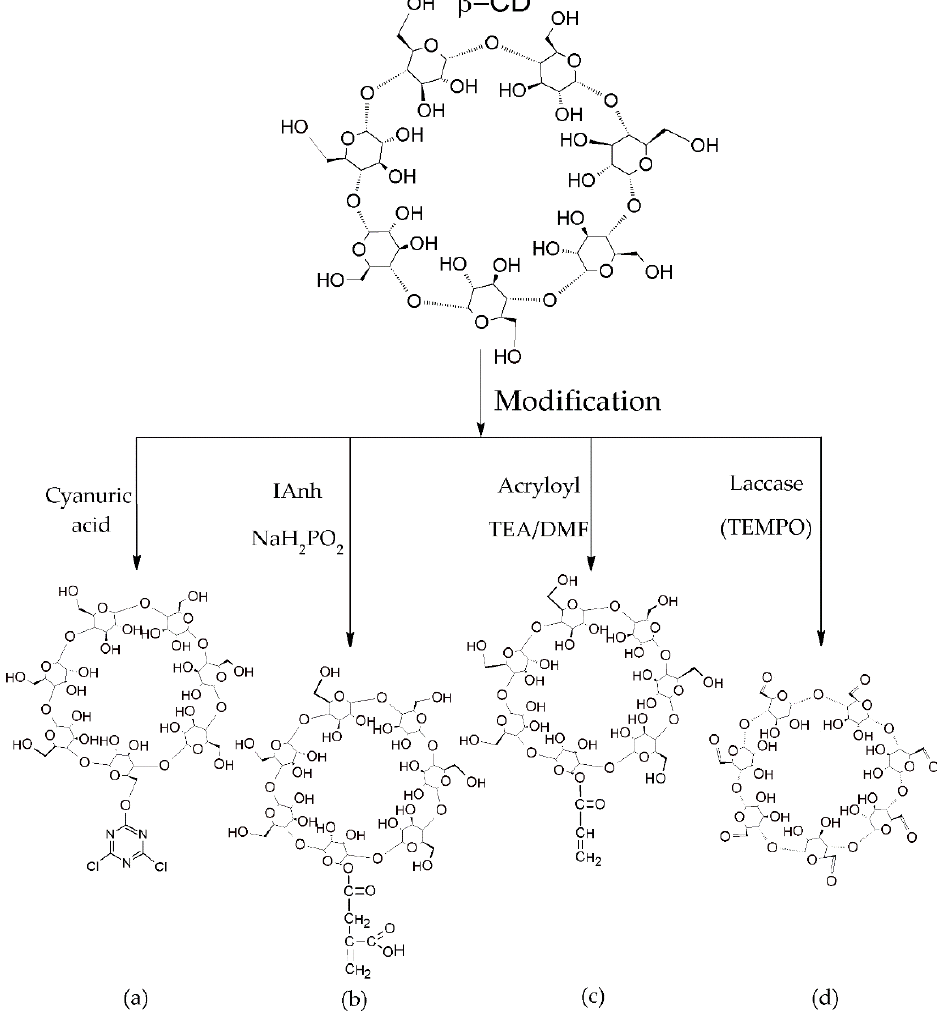
Figure 5. Modification of β -CD by: ( a ) cyanuric acid; ( b ) itaconic anhydride (IAnh); ( c ) acryloyl chloride and ( d ) laccase/2,2,6,6-tetramethylpiperidine-1-oxyl (TEMPO) enzyme .